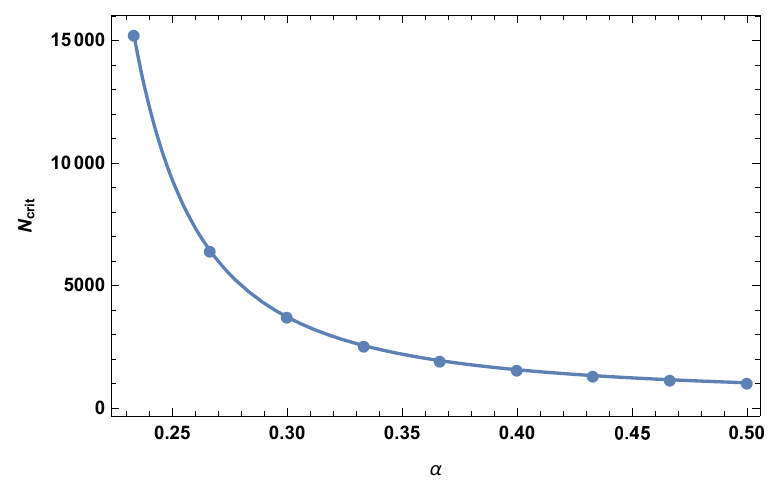
Figure 2 . N crit as a function of α . An IR stable fixed point on the ( g, h ) plane exists only for large enough rank of the O ( N ) group, N